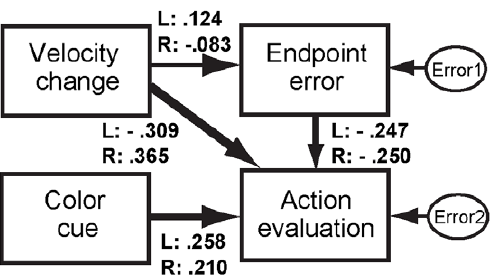
Figure 8. Path diagram in the test phase. In addition to the variables in the practice phase (i.e., velocity change, endpoint error, and action evaluation), a color cue, the color (green or blue) of the fixation point during each trial, was added. The color cue was nominal scale, so we used a dummy variable for the analysis; that is, blue was transformed to 0 and green was transformed to 1. The line width between the variables schematically indicates the strength of the relationship, and each number near the path denotes the mean standardized path coefficient of Mask L and R conditions respectively (see also Table